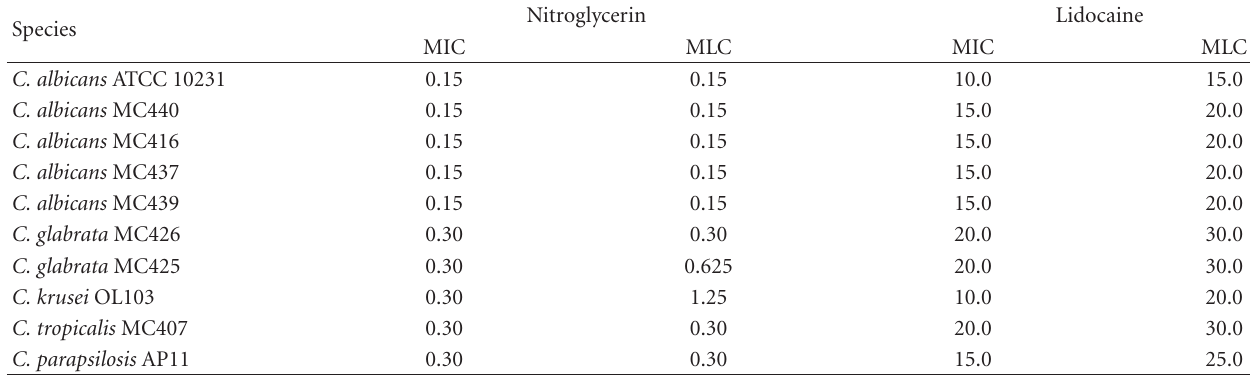
Table 2: Candida spp. susceptibility to nitroglycerin and lidocaine. Minimal inhibitory concentration (MIC) and minimal lethal concentration (MLC) are presented in